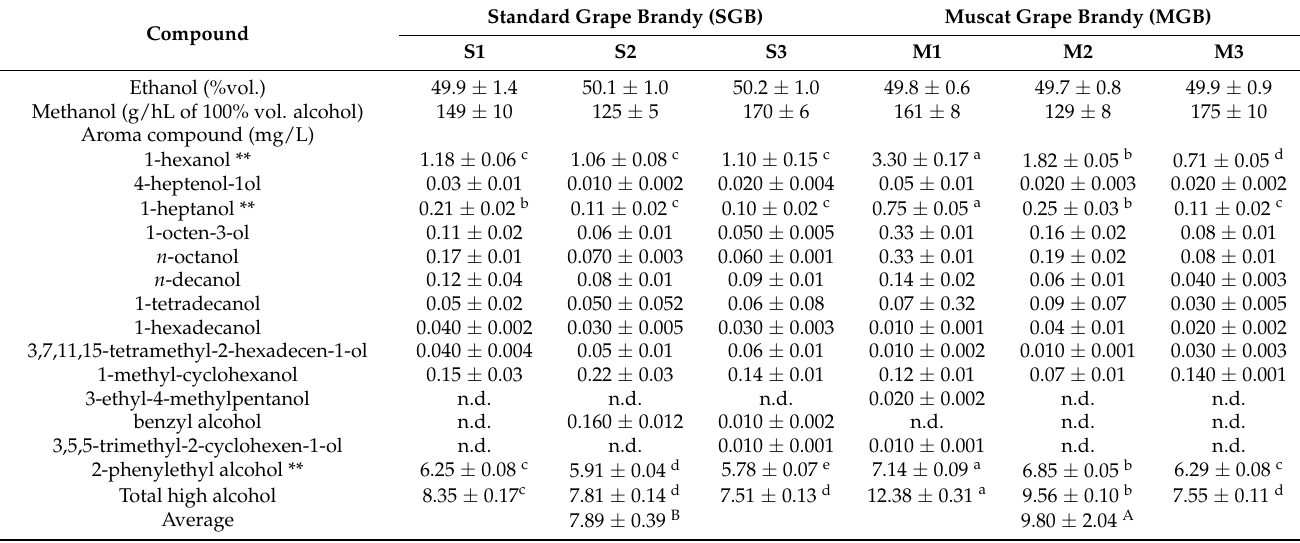
Table 1. Concentration of alcohols in standard and Muscat grape brandies in mg/L *. Standard Grape Brandy (SGB) Muscat Grape Brandy (MGB) Compound S1 S2 S3 M1 M2 Ethanol (%vol.)